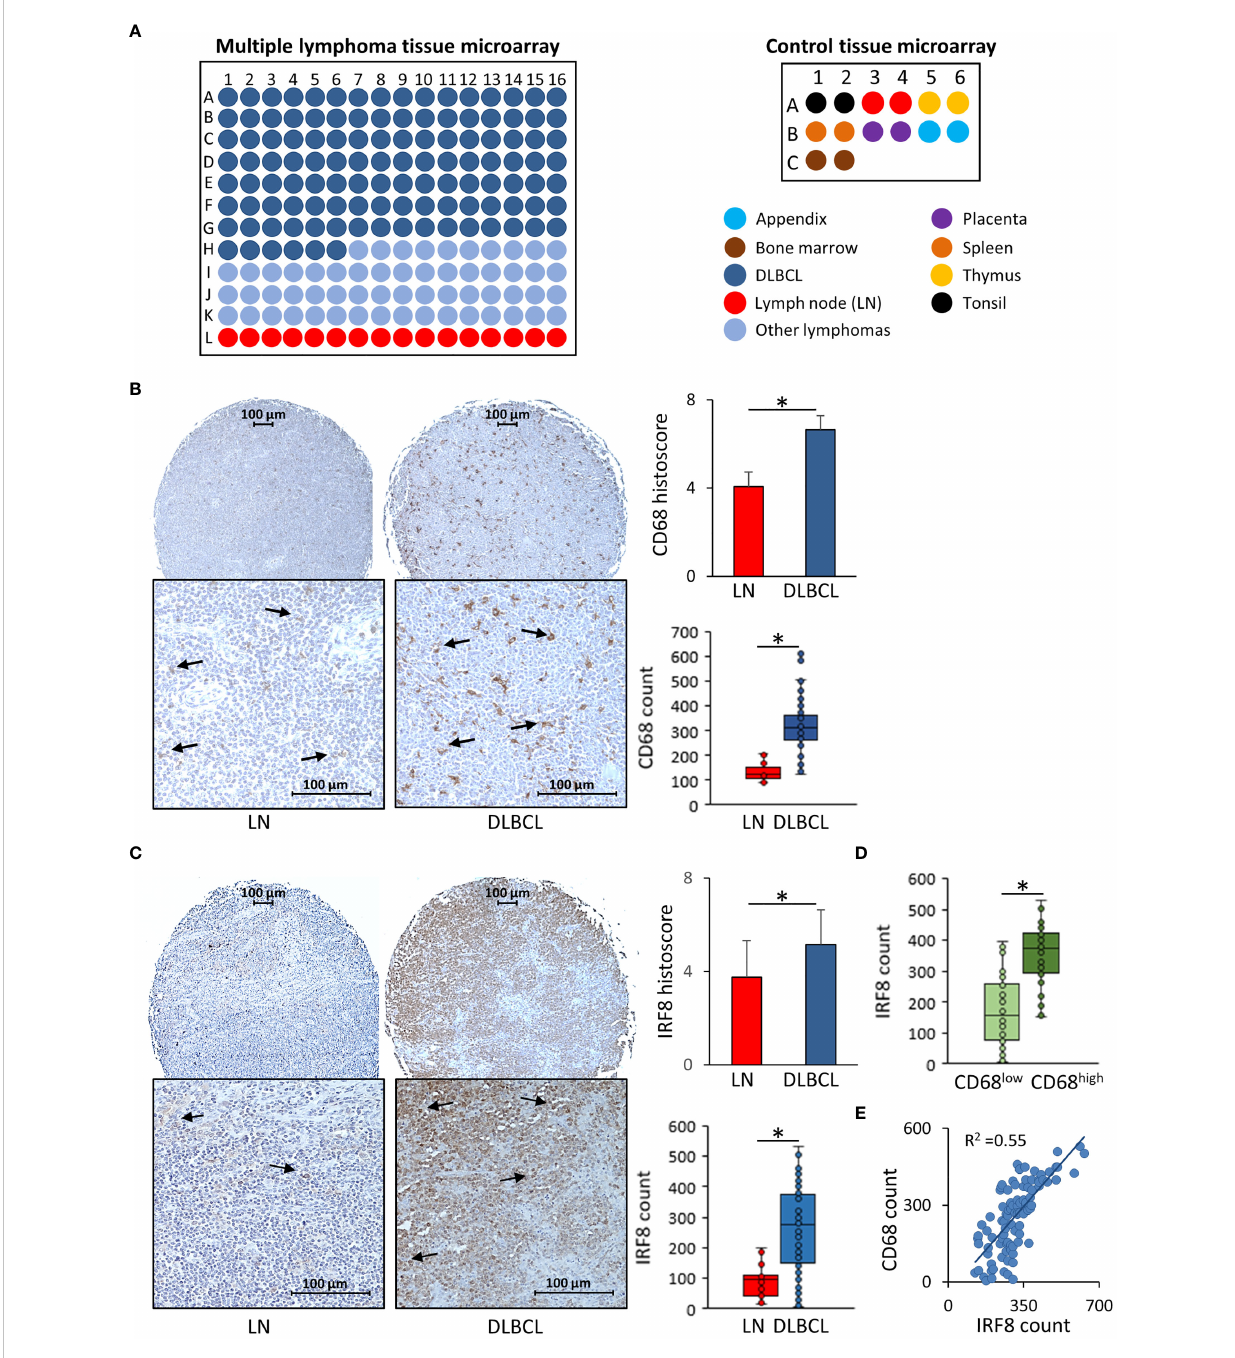
FIGURE 6 Immunohistochemical analysis of CD68 and IRF8 expression in 118 DLBCL samples and 30 normal lymphoid tissue samples (A) Scheme showing the distribution of tumor and normal tissue samples in each slide of the two tissue microarrays. (B) Representative images showing CD68 expression in normal lymph nodes (LN) and DLBCL samples (left panels). Quantitative analysis of the CD68 histoscore and absolute count in DLBCL and LN samples (right panels). (C) Representative images showing IRF8 expression in normal lymph nodes (LN) and DLBCL samples (left panels). Quantitative analysis of IRF8 histoscore and absolute count in DLBCL and LN samples (right panels). (D) IRF8 absolute count in the CD68 low and CD68 high DLBCL groups. (E) CD68 and IRF8 correlation analysis. *P ≤